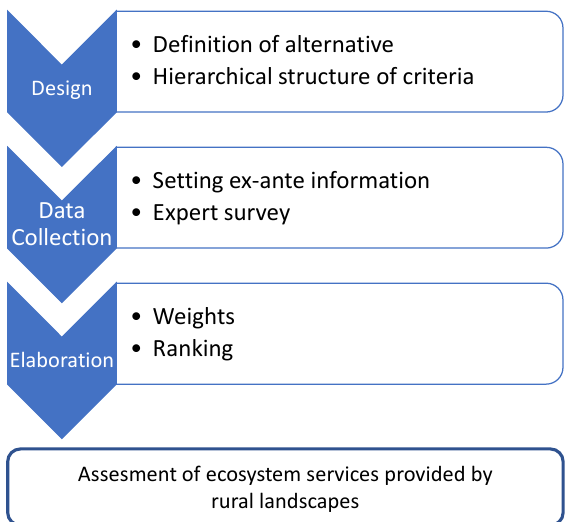
Figure 2. Methodological diagram.